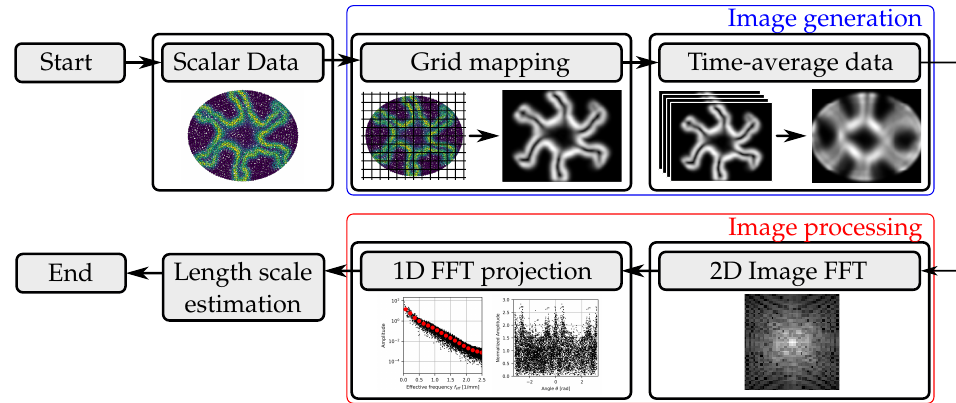
Figure 1. Schematic description of the post-processing method.